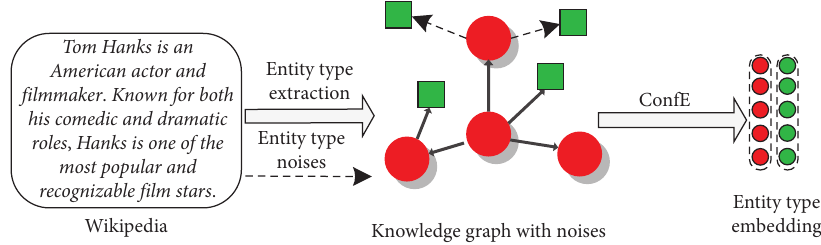
Figure 1: Entity type noises in KGs and learning entity type embeddings with confidence Table 1: Model illustration of KG Noise Detection.